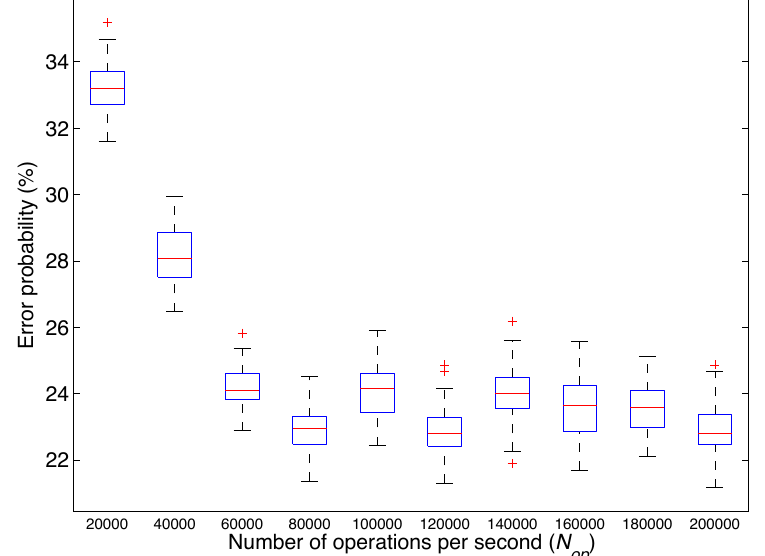
Figure 10. Box plot of the probability of error obtained by the classifiers for different values of the maximum number of operations per second ( N of